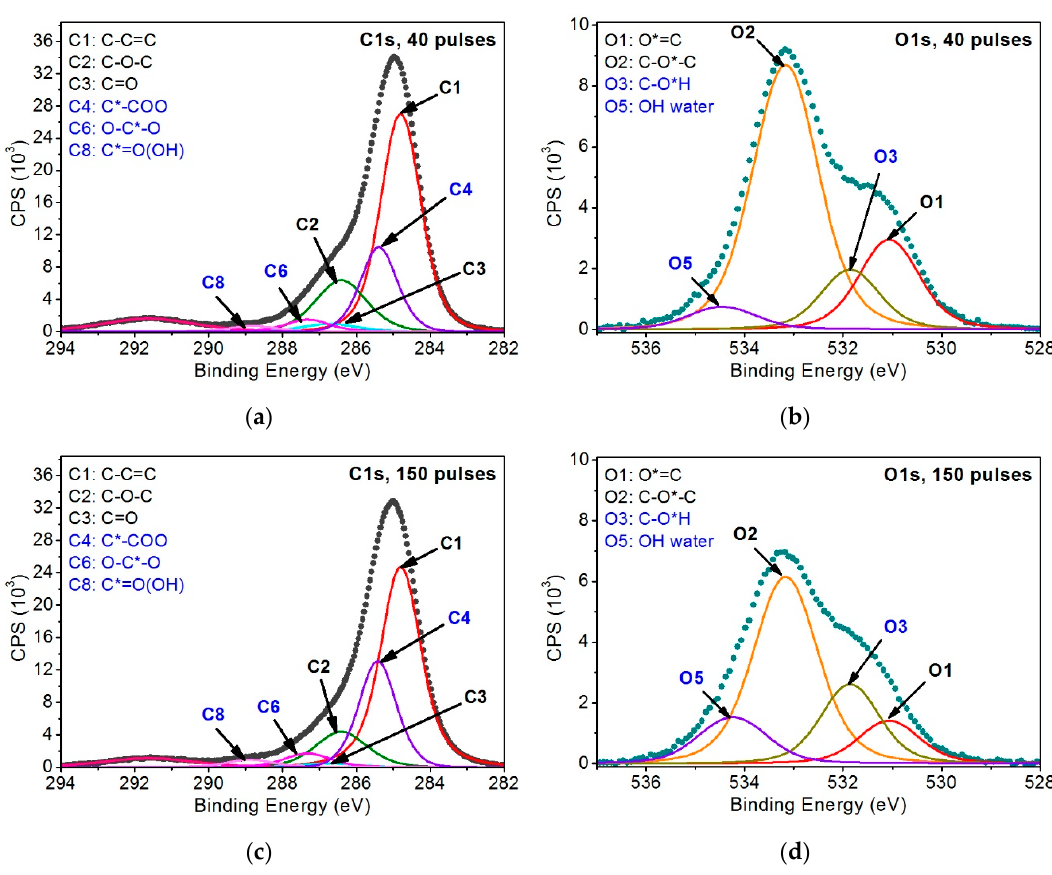
Figure 7. XPS spectra of modified PEEK: ( a ) with 40 EUV pulses—C1s band, ( b ) with 40 EUV pulses—O1s band, ( c ) with 150 EUV pulses—C1s band, ( d ) with 150 EUV pulses—O1s band.